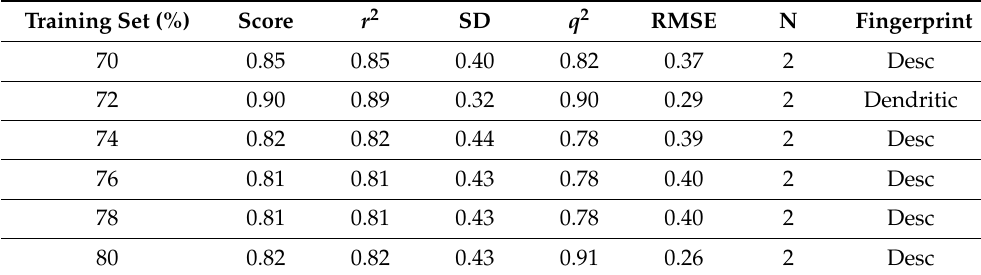
Score: Performance considering training and test set predictive accuracies; r 2 : Coefficient of determination for the training set; SD: Standard deviation; q 2 : Predictive correlation coefficient for the test set ( r 2 pred ); RMSE: Root mean square error for the test set predictions; N: Optimum number of components.